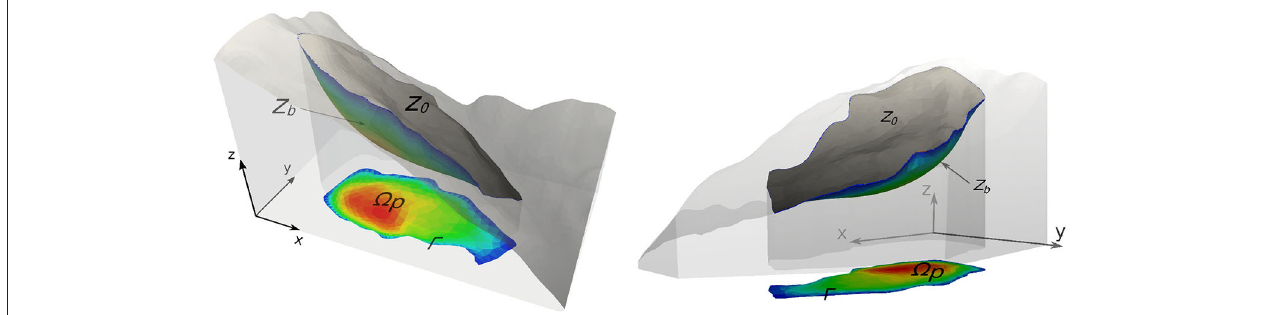
FIGURE 5 | Conceptual sketch, symbols, and coordinate system. The landslide site FID5, defined in Figure 2 is used as an example. Symbols z 0 ≡ z 0 ( x , y ) and z b ≡ z b ( x , y ) are the free surface and underground failure interfaces, respectively. (cid:127) p and Ŵ are the projection of the scarp area and outline on the xy plane, respectively. The scarp failure interfaces and depth are largely exaggerated for clarity in this sketch, and the color map conceptually indicates the scarp